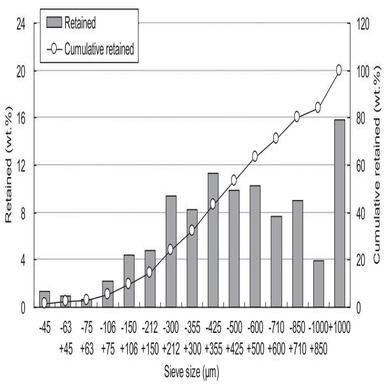
Sieve analysis results of the IGCC slag. The dominant particle sizes ranged from 212 to 600 lm.